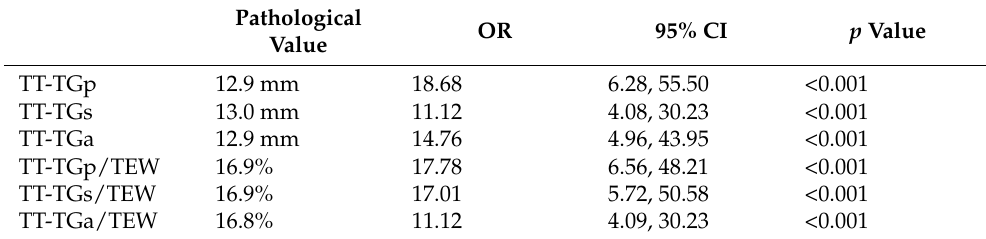
Table 5. Binary logistic regression model of the TT-TG distance parameters for patellar